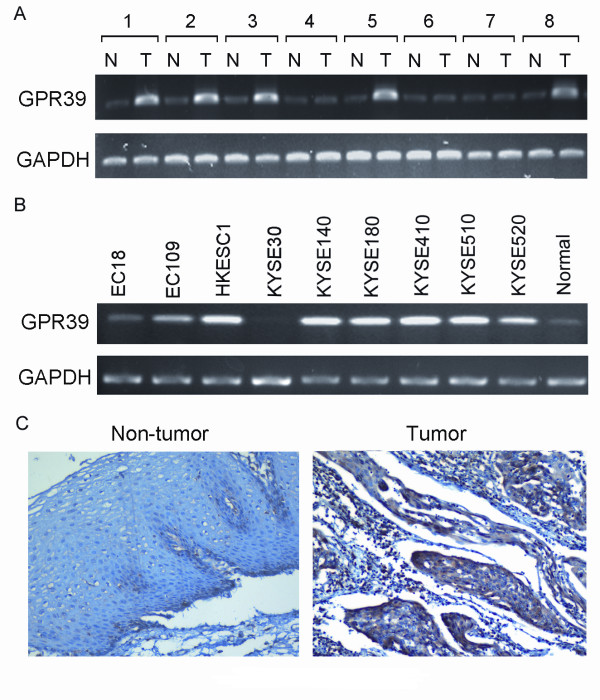
Overexpression of GPR39 in ESCC. GPR39 was frequently overexpressed in primary ESCCs (A) and ESCC cell lines (B) detected by RT-PCR. For primary ESCCs, expression of GPR39 in tumor tissues (T) was compared with their paired non-tumorous tissues (N). Normal esophageal tissue was used as a normal control. 18S rRNA was used as an internal control. (C) Representative of GPR39 expression in a pair of ESCC (right) and adjacent normal tissue (left) detected by immunostaining with anti-GPR39 antibody (brown). The slide was counterstained with hematoxylin (original magnification × 200).